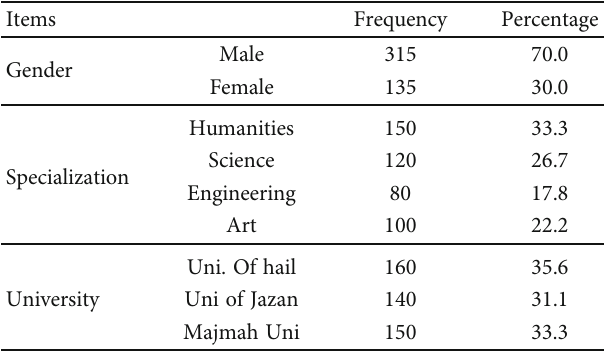
Table 1: Demographic distribution of